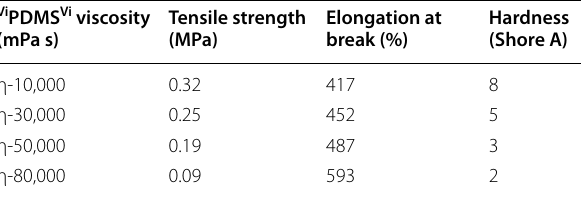
Table 4 Effect of active hydrogen content on mechanical properties of PDMS polymer film